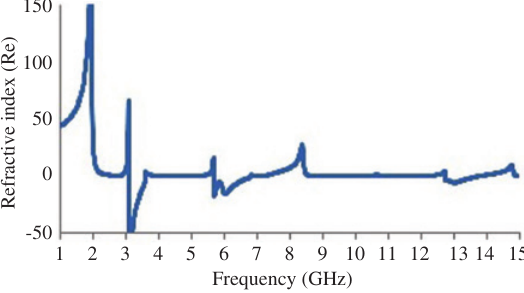
Figure 10: Real value of refractive index ( η ) versus frequency for the y- axis wave